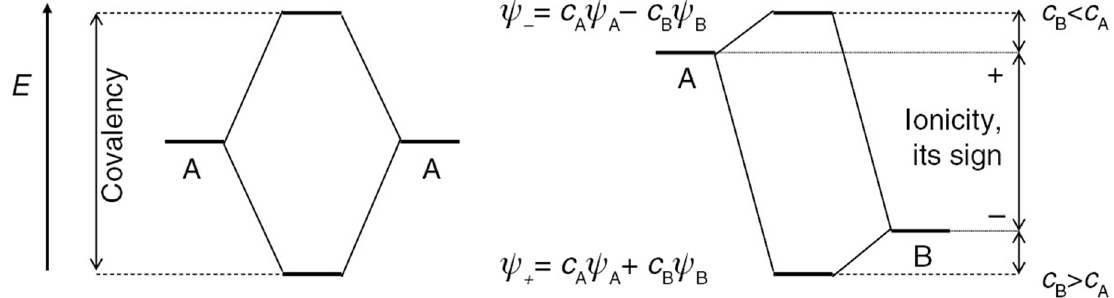
Figure 1. Simple MO schemes for two species A and B with electronic states ψ A and ψ B . Left: formation of a homonuclear bond without polarization. Right: formation of a polarized heteronuclear bond with two resulting states ψ − and ψ + as a result of the linear combination of atomic orbitals with coefficients c A,B . Reproduced with permission from Ref. [7], used in accordance with the Creative Commons Attribution (CC BY-NC-ND 4.0) license (https://creativecommons.org/licenses/by-nc-nd/4.0/, accessed on 20 August